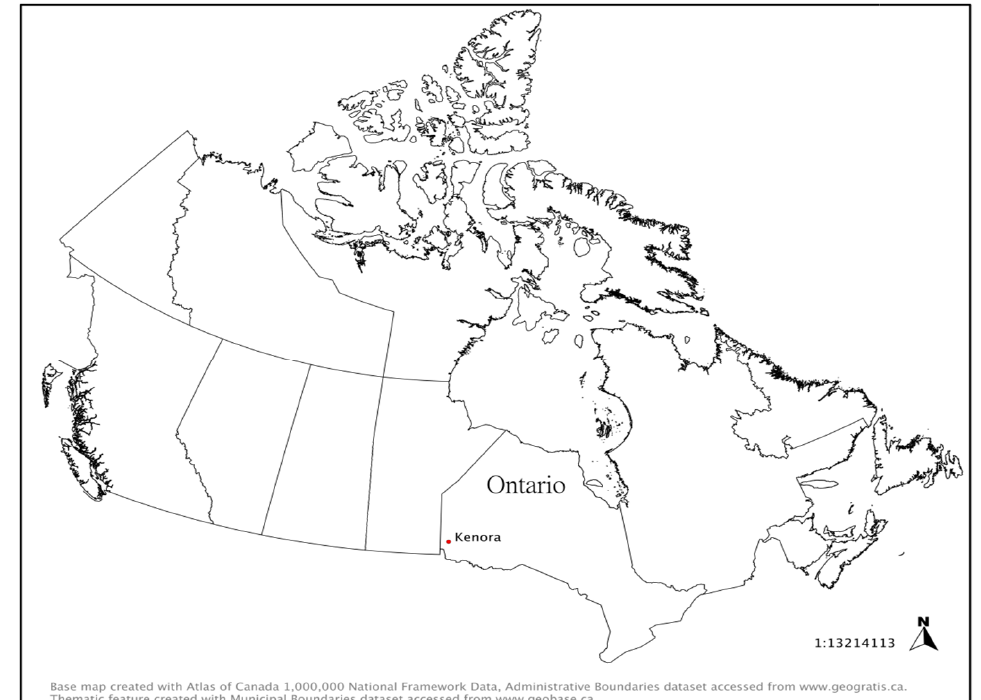
Figure 1.1 – Location of